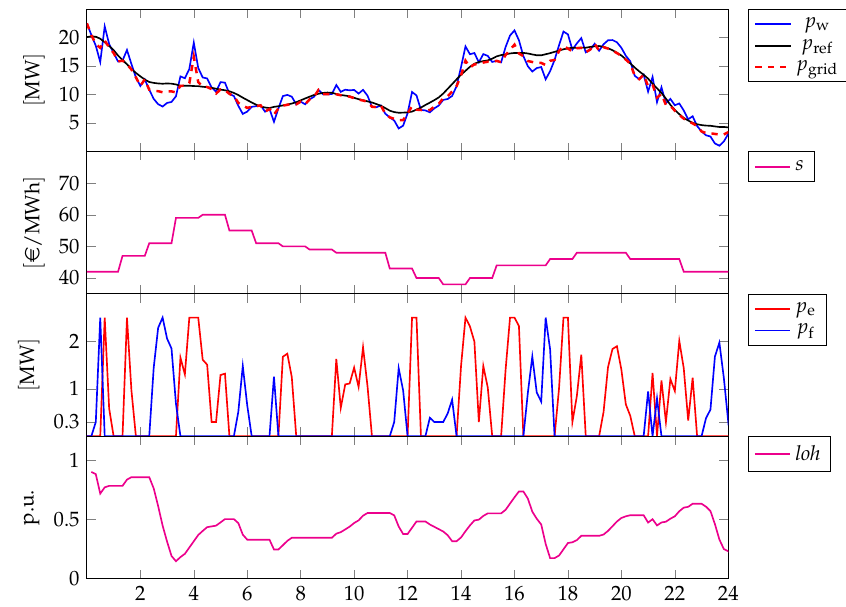
Figure 8. Different profiles related to the reference period from 14:40 of Sat 18 th Feb, 2017 to the same hour of Mon 20 th Feb, 2017, for highlighting the impact of c loh N . First graph: power by wind generation (blue line) and power delivered to the grid (dashed red line); Second graph: power of the electrolyzer (red line) and power of the fuel cell (blue line); Fourth graph: LoH.